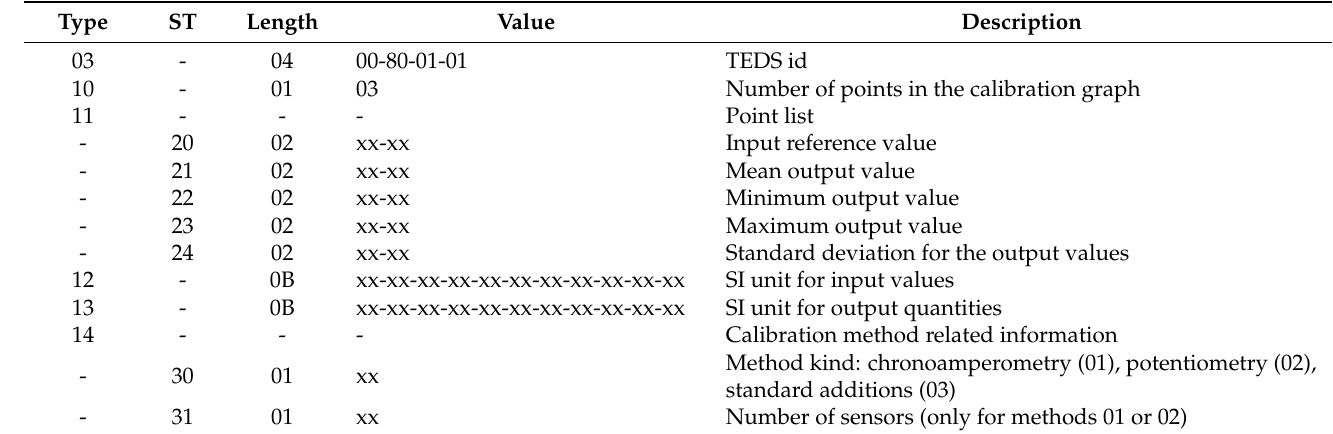
Table 5. Example of manufacturer-defined Calibration TEDS for a biosensor.